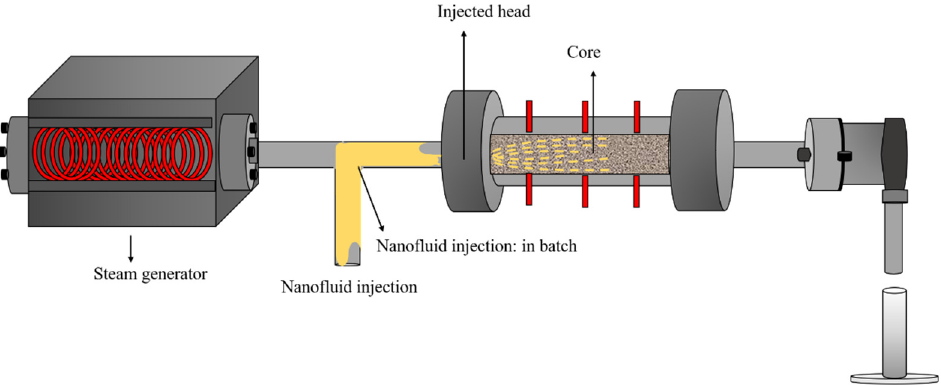
Figure 2. Graphical representation of nanofluid injection in batch into the porous